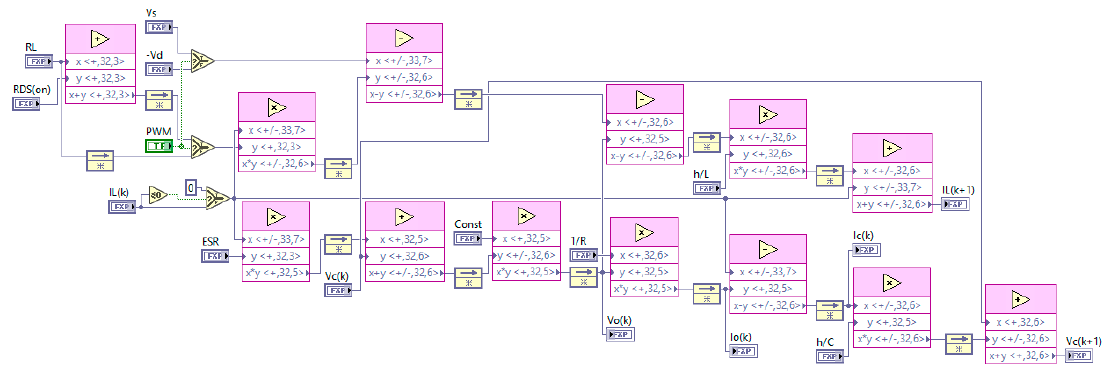
Figure 8. Implementation of Equations (12)–(14) in Field-Programmable Gate Arrays (FPGA) using LabVIEW predefined Digital Signal Processor (DSP) blocks.